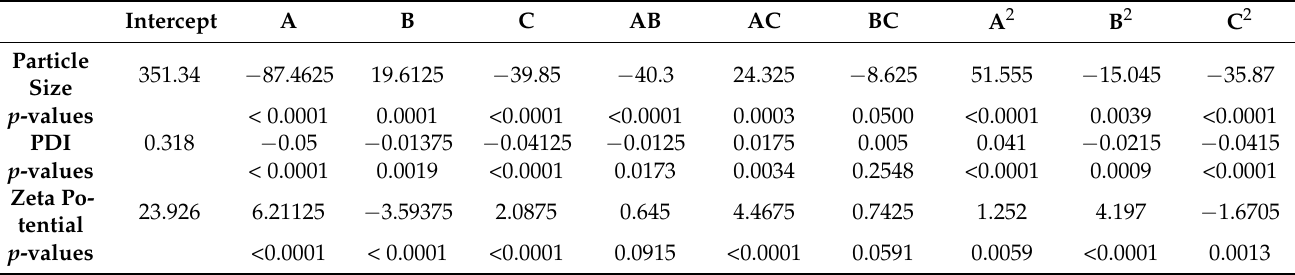
Table 4. Analysis of variance (ANOVA)